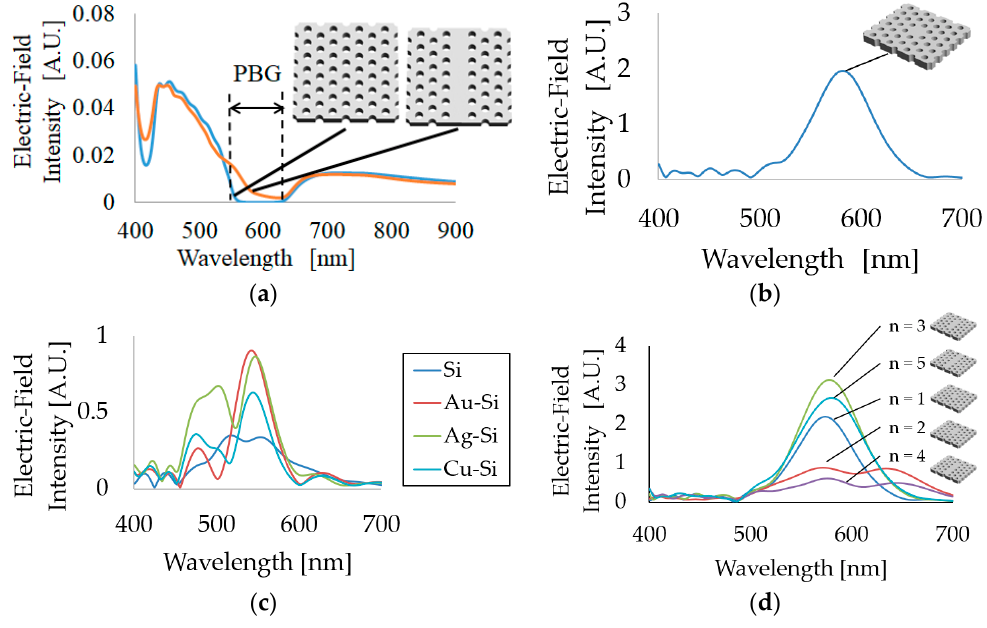
Figure 3. Results of simulations conducted to optimize PhC structure. ( a ) PhC and PhC waveguide, ( b ) PhC resonator, ( c ) PhC resonators with different substrates, ( d ) PhC resonators with different numbers of cavities. PBG, photonic band gap.